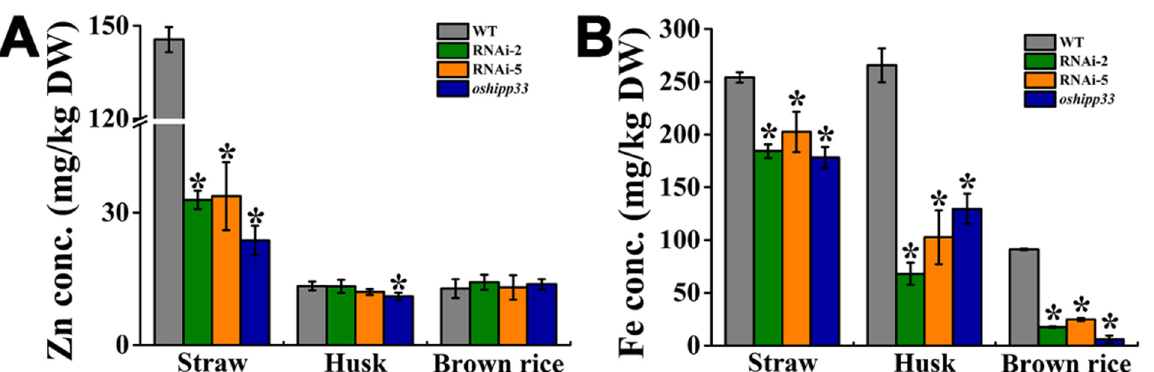
Figure 5. Zn and Fe concentrations in different rice tissues at maturity stage of OsHIPP33 mutant, RNAi lines and wild-type (WT). The rice varieties were grown in a field under natural conditions for two successive year trials. ( A ) Zn concentration. ( B ) Fe concentration. The vertical bars indicate the means of biological triplicates and the asterisks show the significant difference between the mutant lines and WT ( p < 0.05).